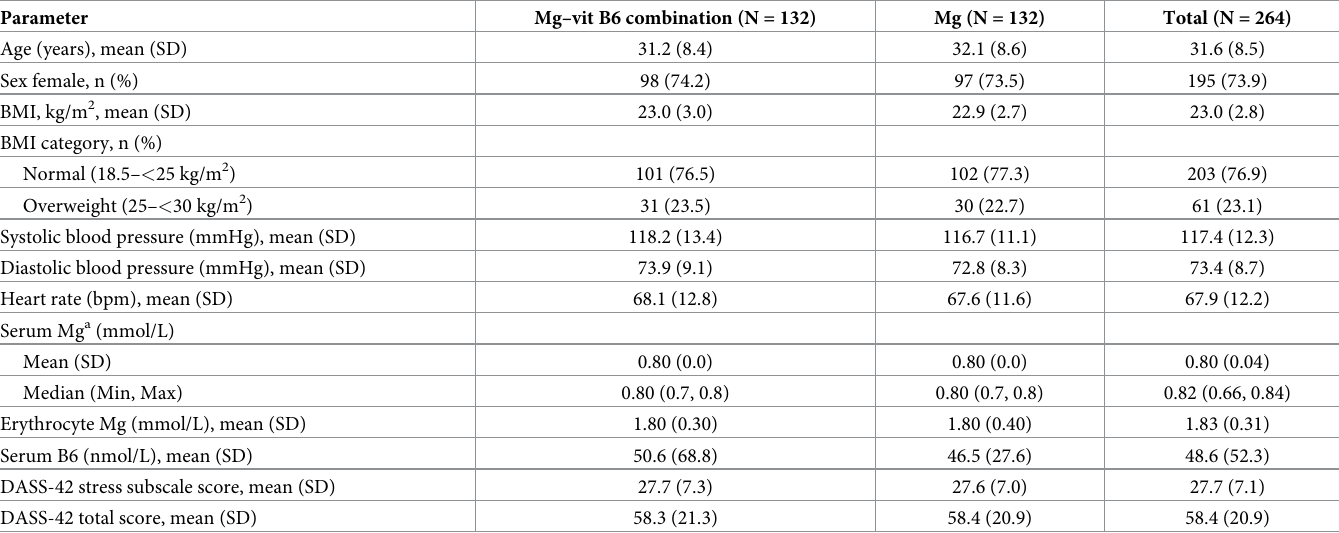
Table 1. Participant demographic and disease characteristics at baseline (mITT